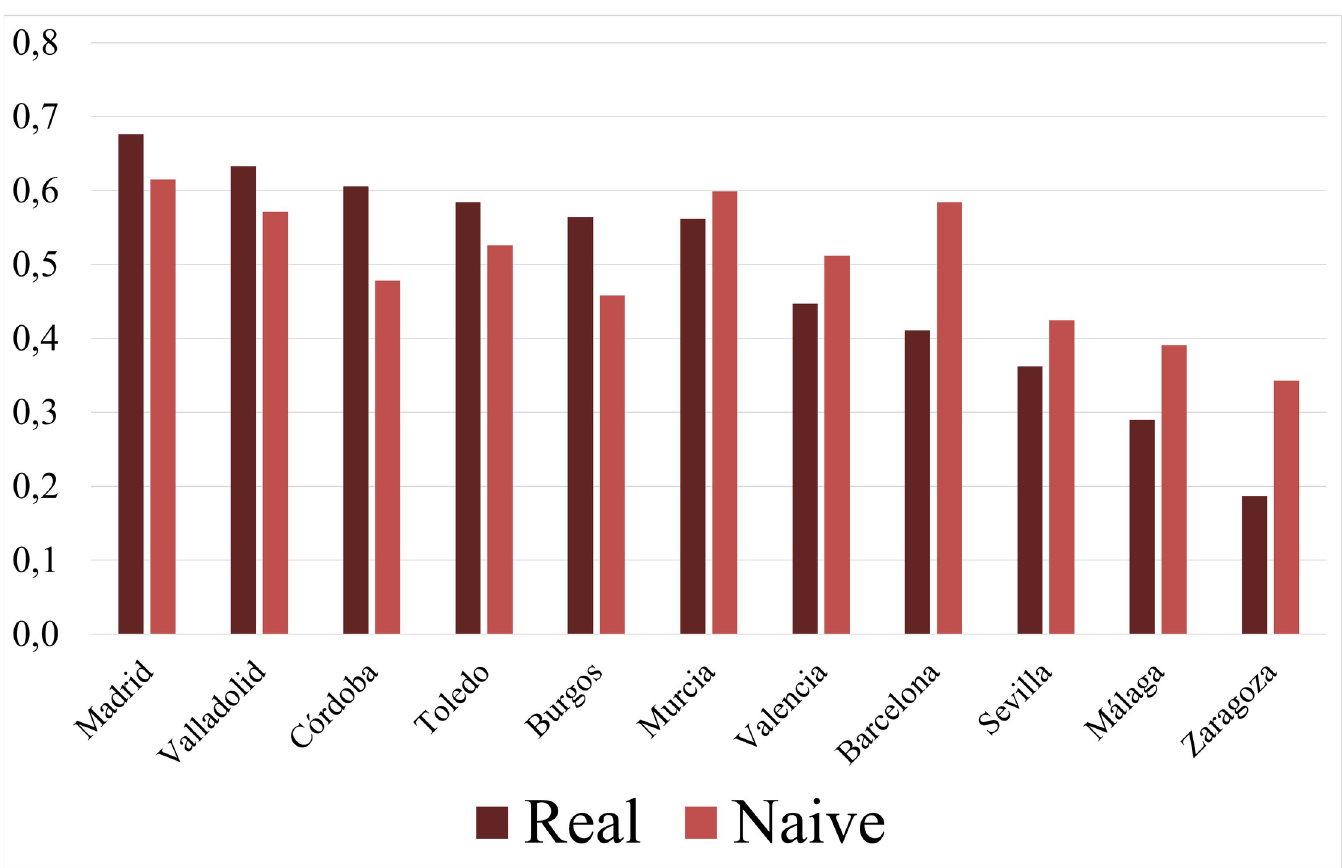
Fig 14. Preferred locations for the capital. Source: Produced by the authors from the networks shown in Figs 10 and 11 and populations from Correas [163].